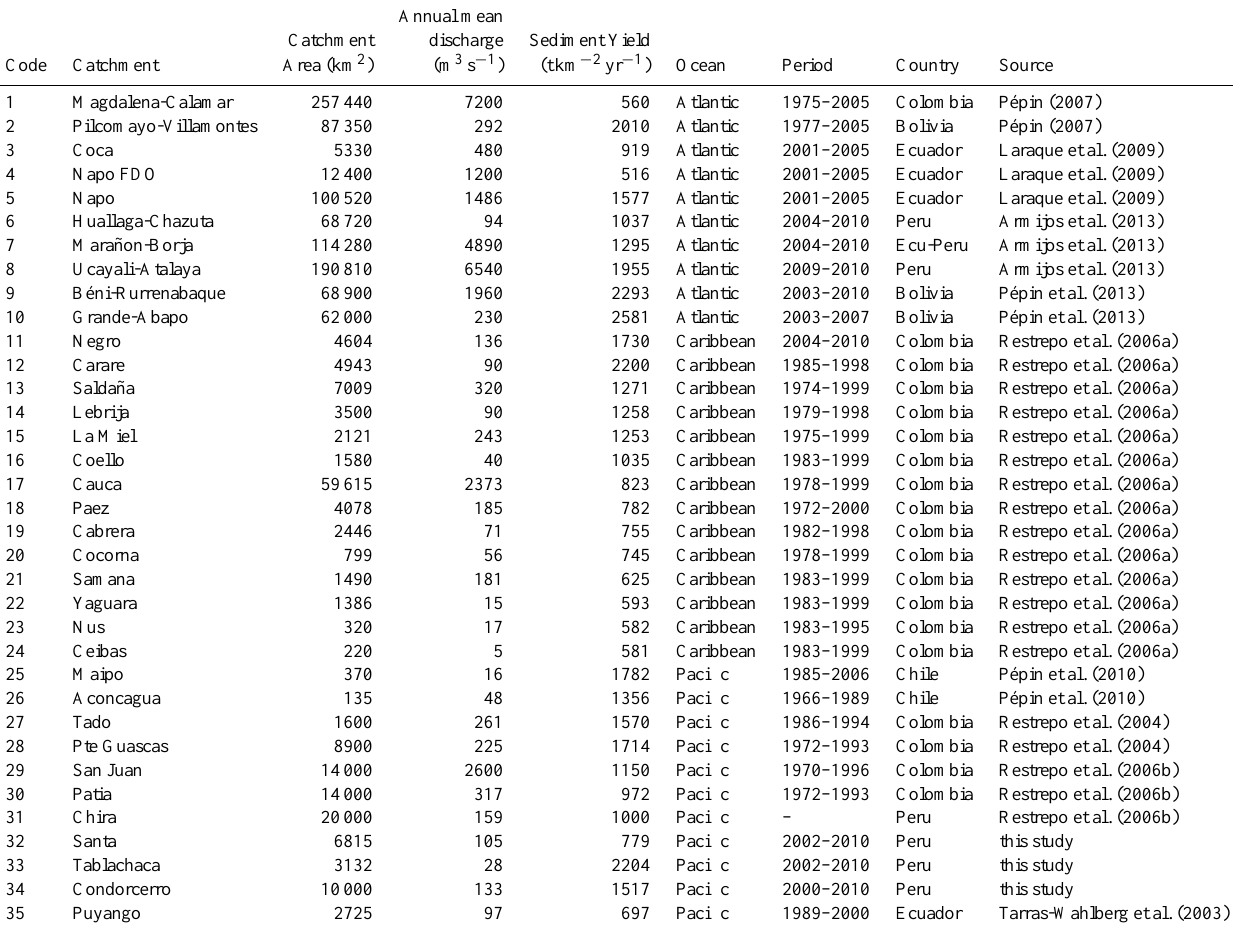
Table 3. Overview of the average to the highest amount of sediment production coming from the Andes mountains; each monitoring location is shown in Fig. 1. Santa (32), Tablachaca (33) and Condorcerro (34) rivers are the dark shaded